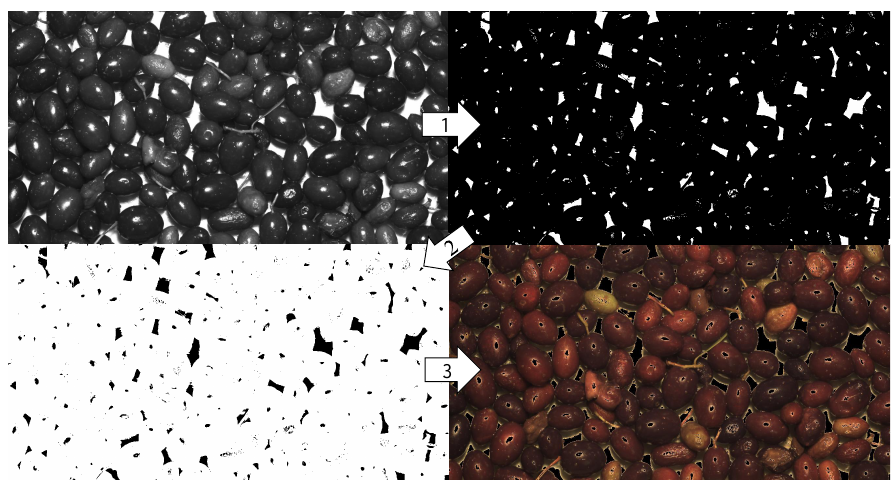
Figure 3. Image processing for features